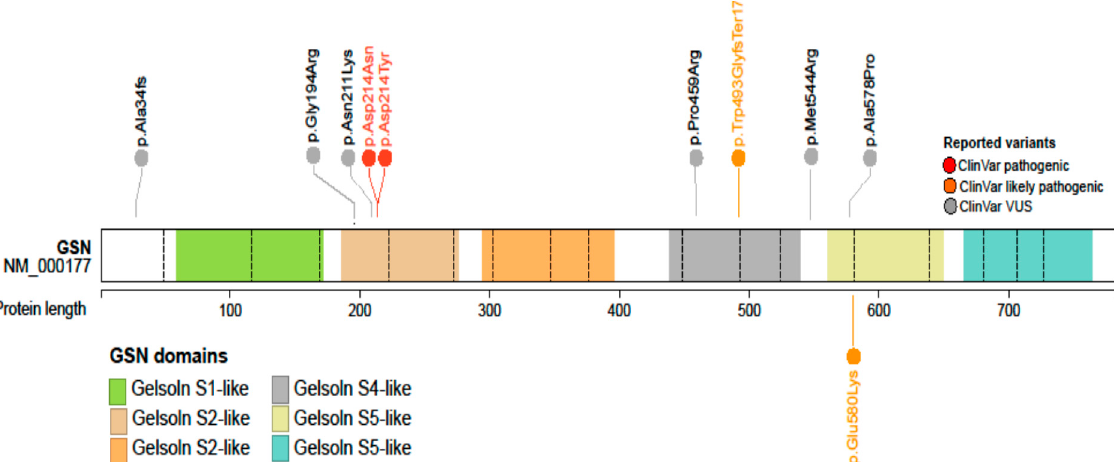
Figure 6. GSN variants with their location in the GSN protein and their pathogenicity designation according to the ClinVar database (Available online: ncbi.nlm.nih.gov/clinvar/ (accessed on 5 December 2020)). The phenotypes that were reported in association with these variants are listed in Table 2. Note the mutation p.Trp493GlyfsTer17 that was designated as likely pathogenic but not yet described in patients in the literature.